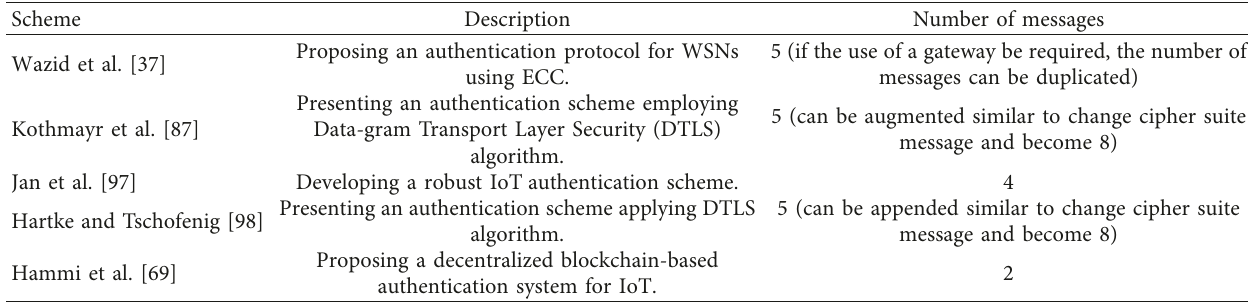
Table 8: Comparison of authentication schemes based on association